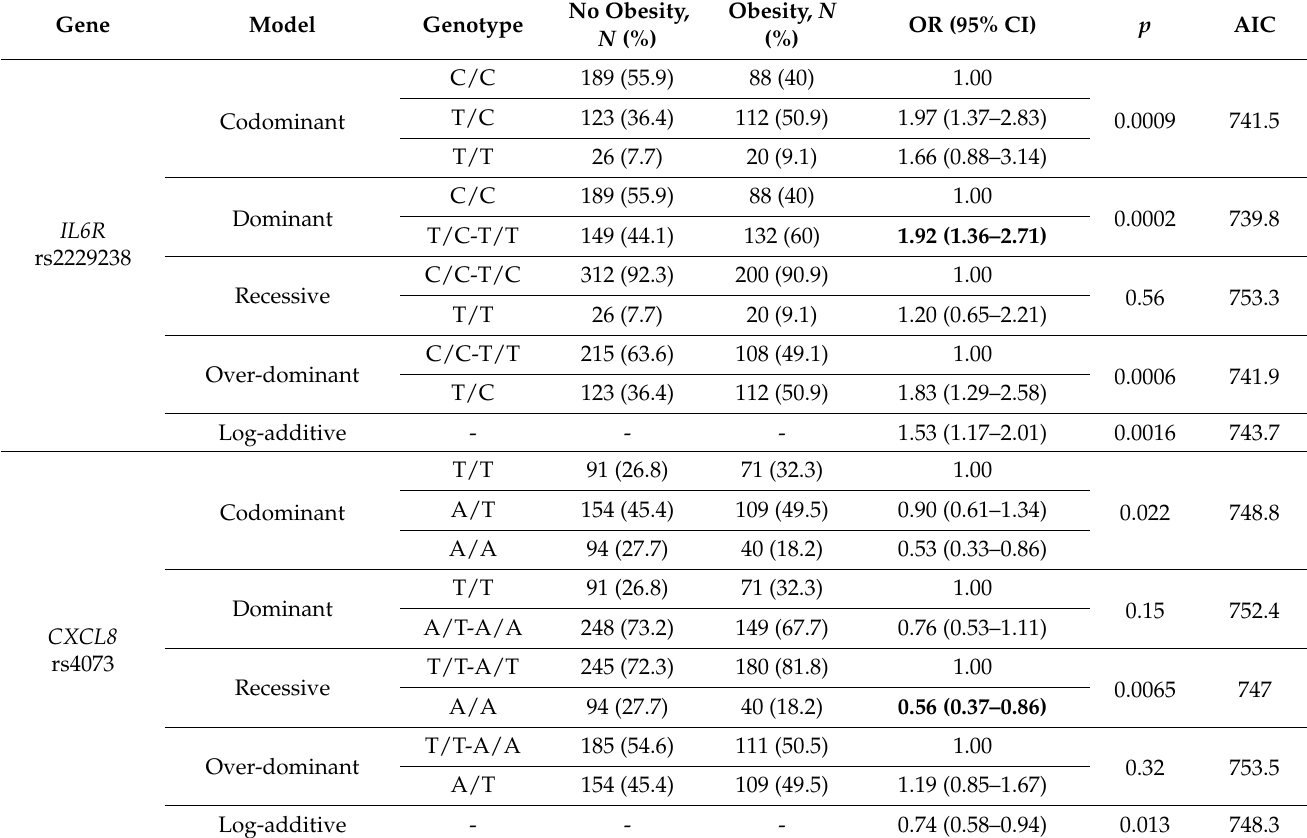
Table 3. Association of SNPs with risk of obesity, adjusted by gender and